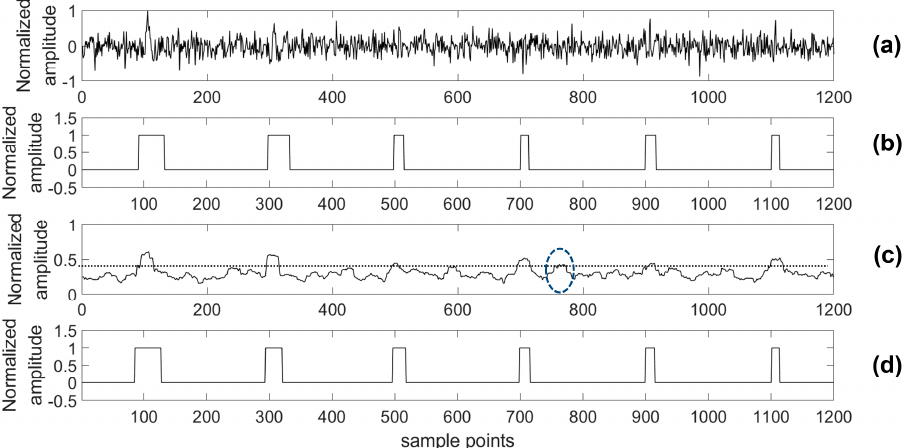
Figure 18. Channel A of test data ( − 15 dB) and its results. ( a ) Test data ( − 15 dB); ( b ) Detection results of the proposed algorithm; ( c ) Detection results of the STA/LTA algorithm; ( d ) The real label.